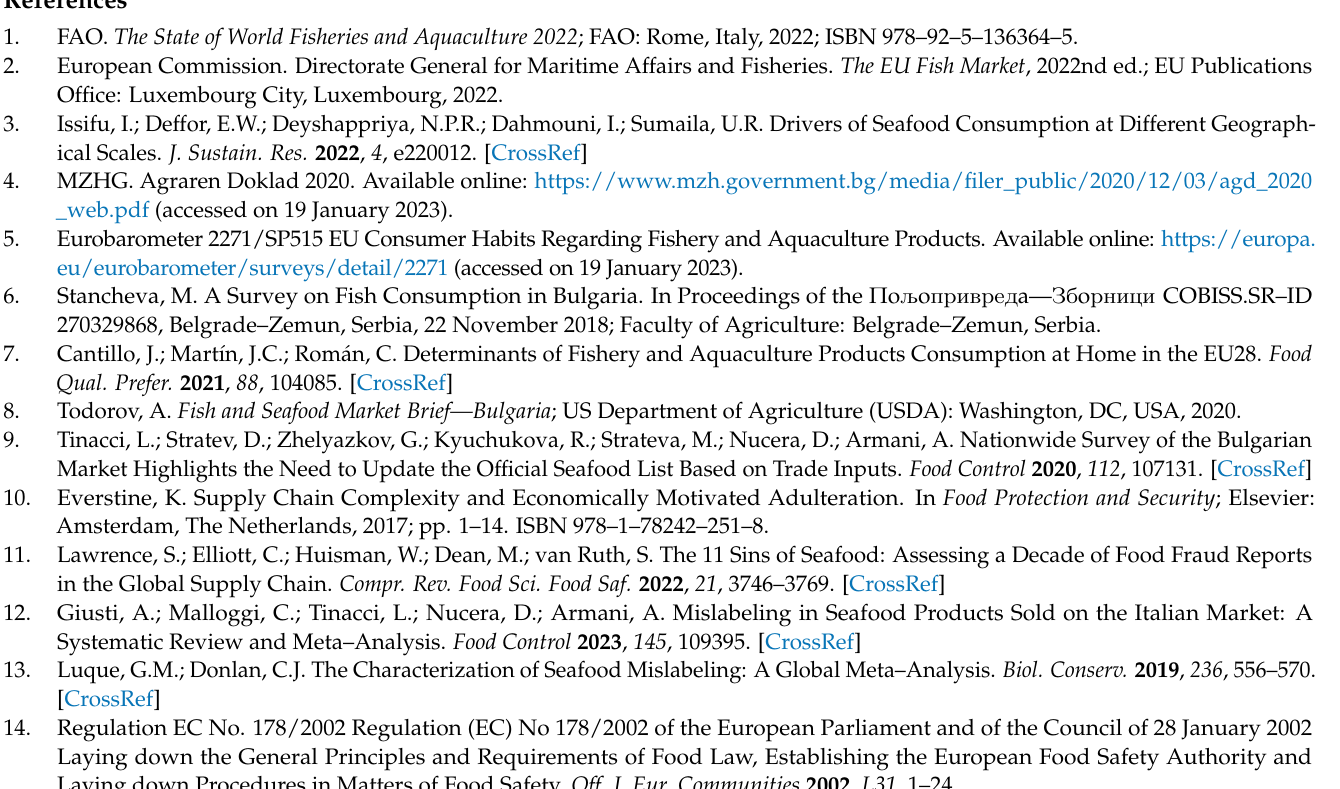
Table S2: Results of molecular analysis of the products. Mislabeled products are highlighted in grey; Table S3: Estimates of interspecies divergence rate over sequence pairs between groups conducted with K2P model on a selection of 32 reference sequences deposited for R. venosa (N = 10); R. bezoar (N = 10); R. rapiformis (N = 7); T. cornutus (N =